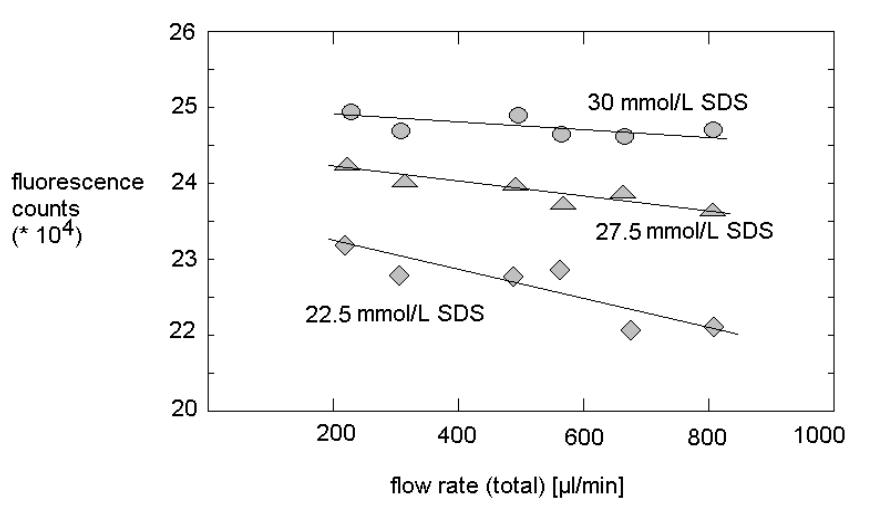
Figure 6. Flow-induced reduction of fluorescence intensity for different SDS